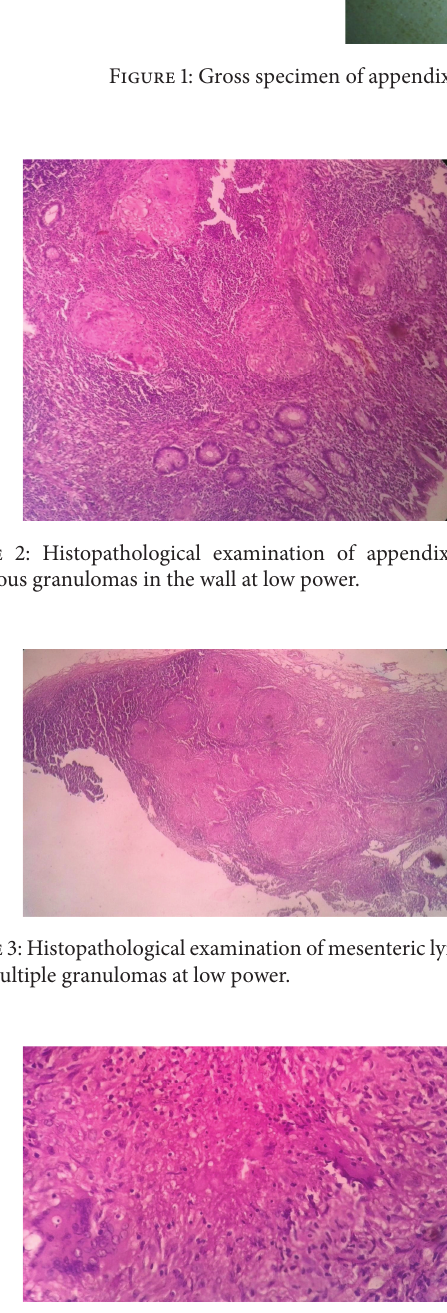
Figure4:Histopathologicalexaminationofappendixshowingcase- ation in the centre with surrounding multinucleated giant cells and epithelioid histiocytes at high